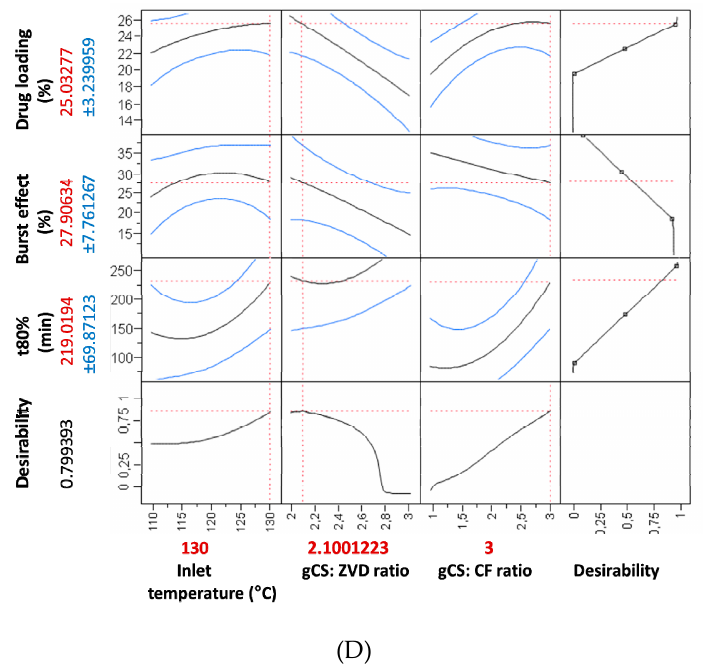
Figure 1. Predicted optimal factors settings (in red) for each studied response, with the use of a maximized desirability function. ( A – C )—the individual optimization of each factor, ( D )—the simultaneous optimization of all the studied factors.